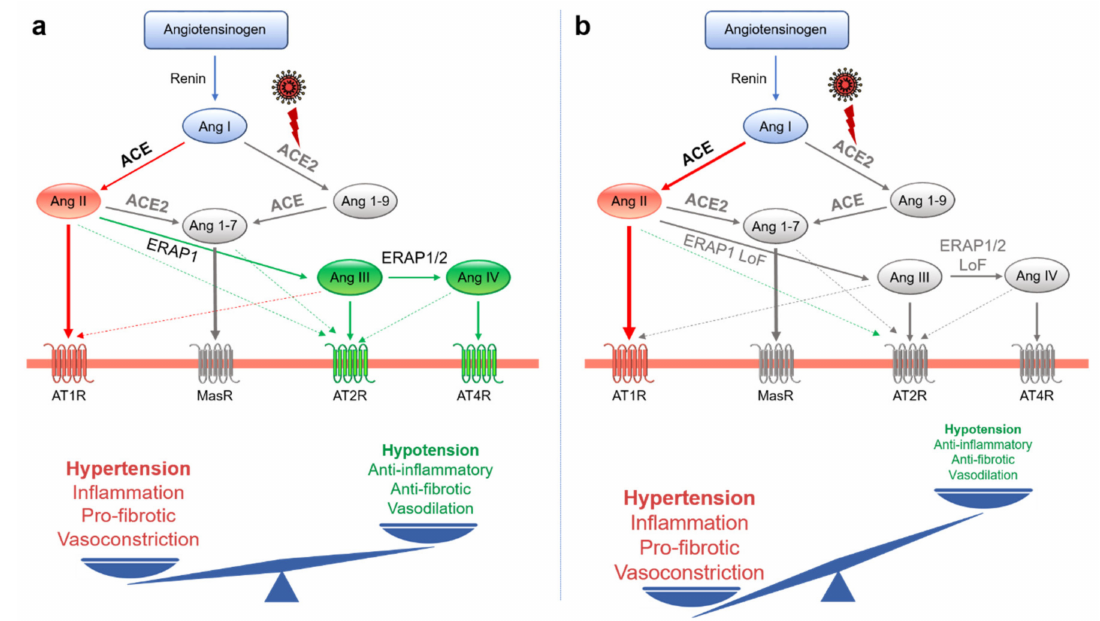
Figure 4. Schematic illustration of the renin-angiotensin system (RAS) in COVID-19 patients with functional ( a ) and dysfunctional ( b ) ERAP1 and ERAP2 enzymes. SARS-CoV-2 infection leads to ACE2 depletion, triggering an imbalance in the RAS, which allows for the accumulation of Ang II and a reduction of Ang-(1-9) and Ang-(1-7) substrates ( a ). This phenotype is further exacerbated in COVID-19 patients with dysfunctional ERAP1 and ERAP2 enzymes ( b ). The non- functional elements of the axes are shown in gray. LoF: loss of